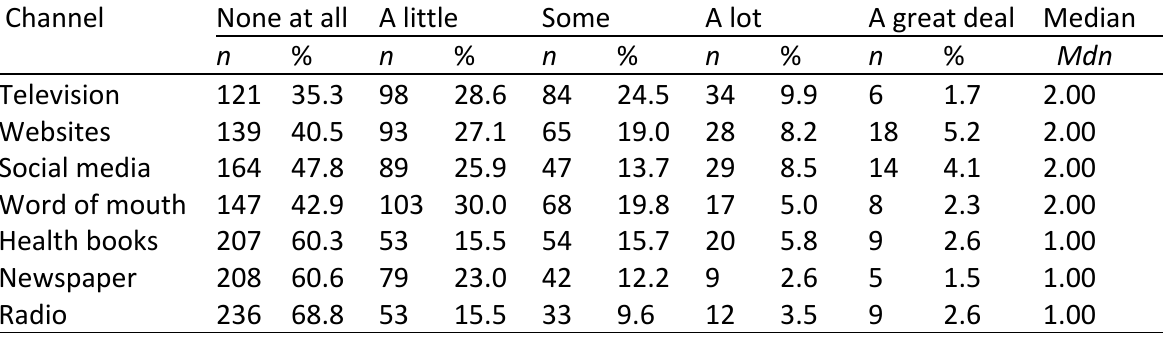
Information Channel Use Among Respondents with Neutral Perceptions of GMO Products (N =